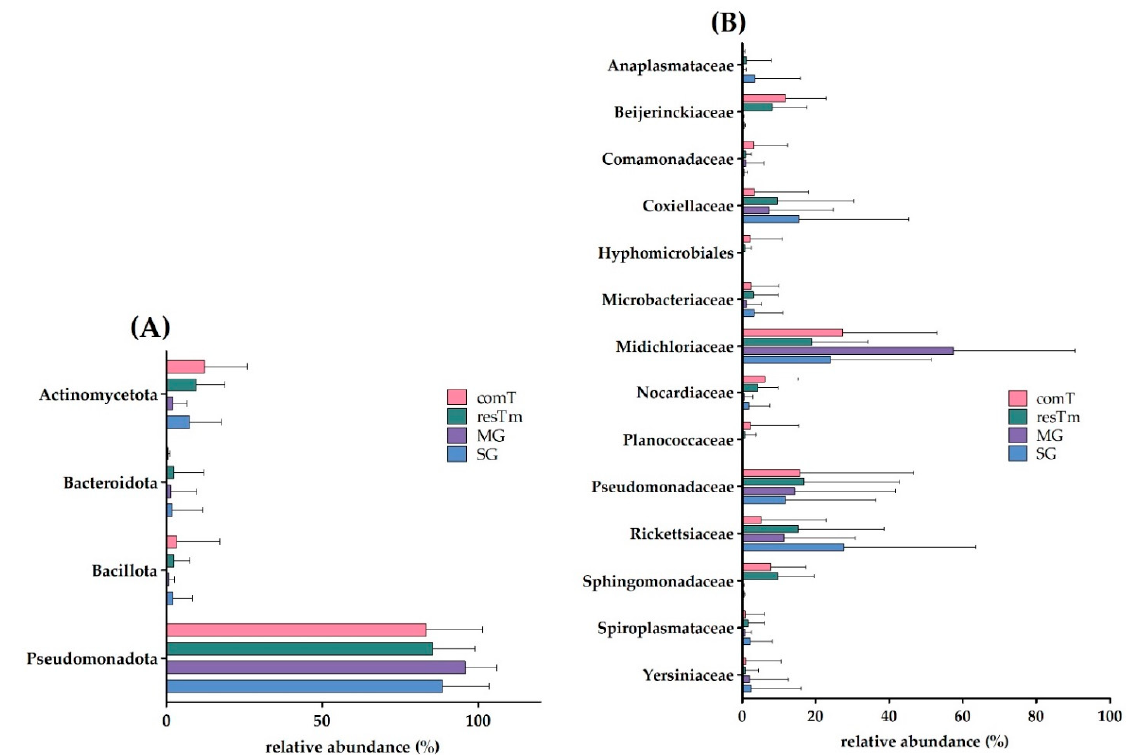
Figure 2. Bar-plots of ( A ) the four most abundant bacterial phyla and of ( B ) the fourteen most abun- dant bacterial families for all types of samples. The end of the bars displays the mean relative abun- dances (%), while the error bars indicate the standard deviation. comT, complete Ixodes ricinus tick; resTm, residual tick material; MG, midgut; SG, salivary